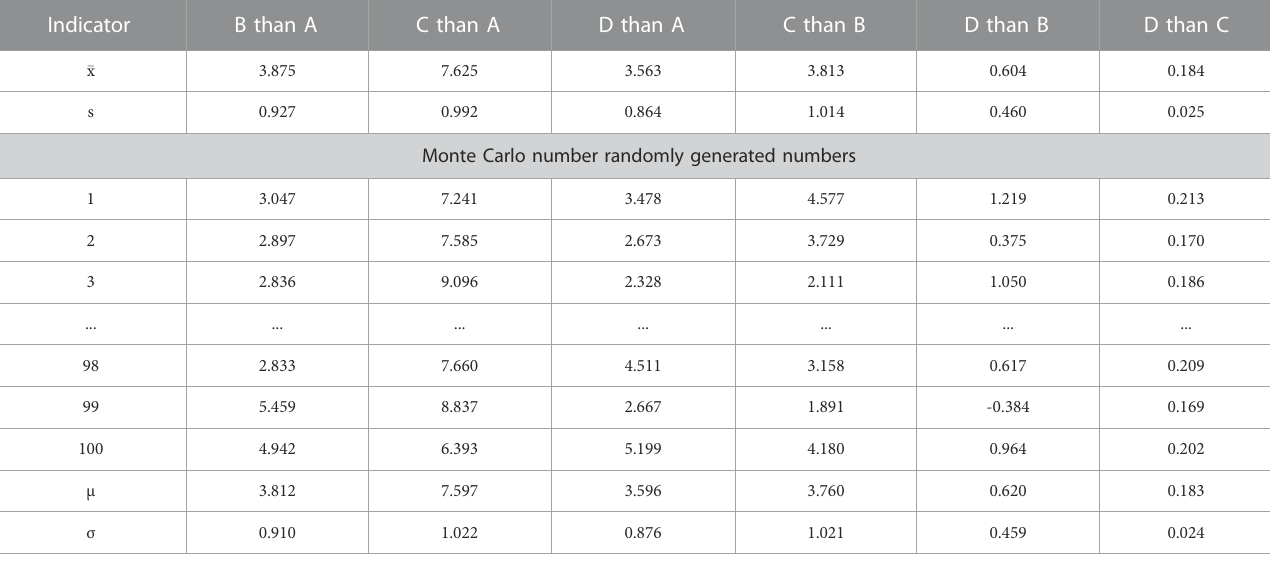
TABLE 2 Monte Carlo random generation number of criterion